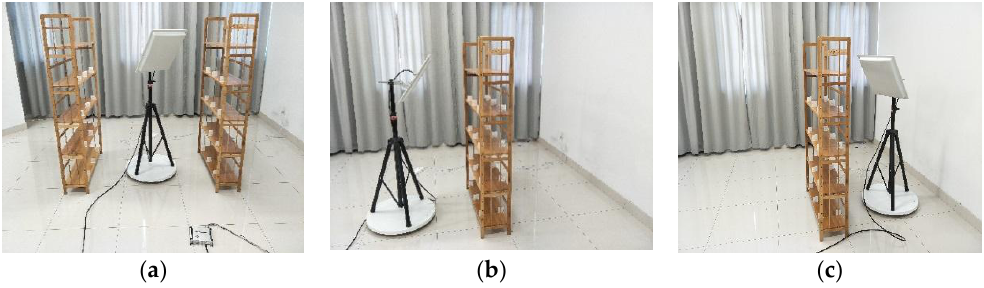
Figure 15. Experimental scenarios. ( a ) two-dimensional (2D); ( b ) three-dimensional (3D); and, ( c ) three-dimensional (3D).